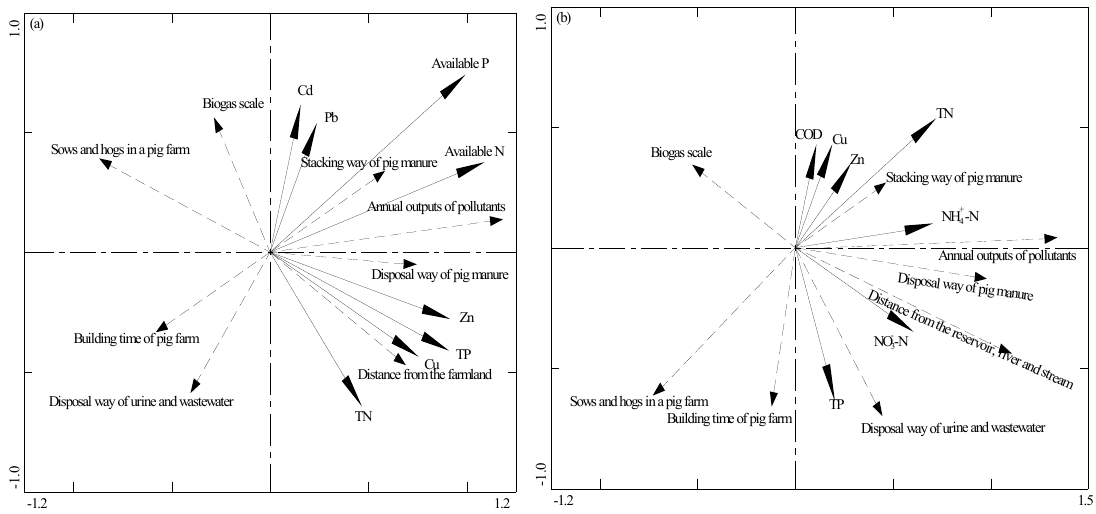
Figure 2. Redundancy discrimination analysis bi-plot showing the impact factors on soil environment ( a ) and water environment ( b ).